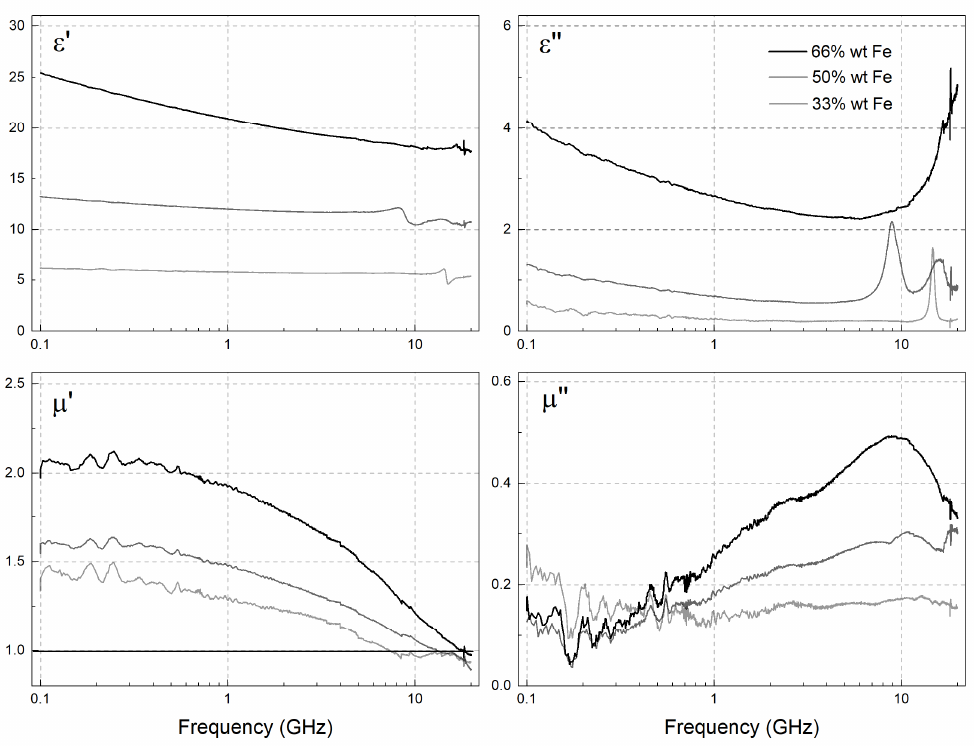
Figure 7. The measured frequency dependences of microwave permeability ( μ′ + i · μ″ ) and permittivity ( ε′ + i · ε″ ) of the composites comprising the paraffin wax matrix and the “Fe” powder.